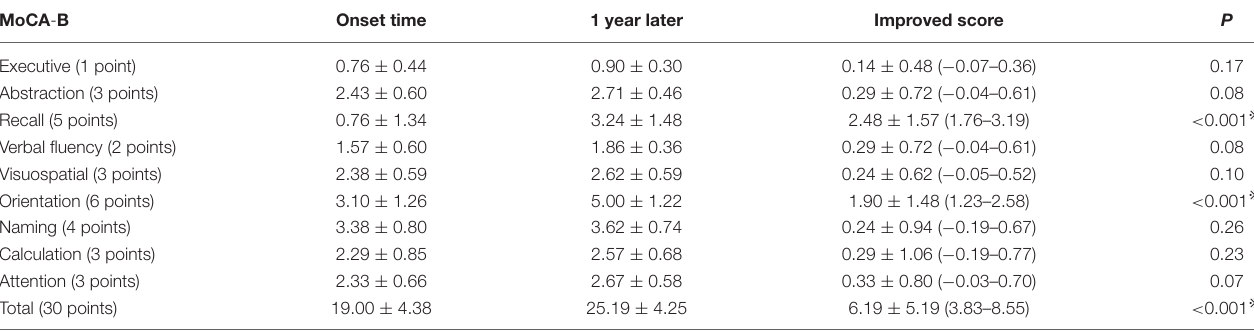
TABLE 3 | Domains of MoCA-B test in patients with anti-LGI1 antibody encephalitis. MoCA -